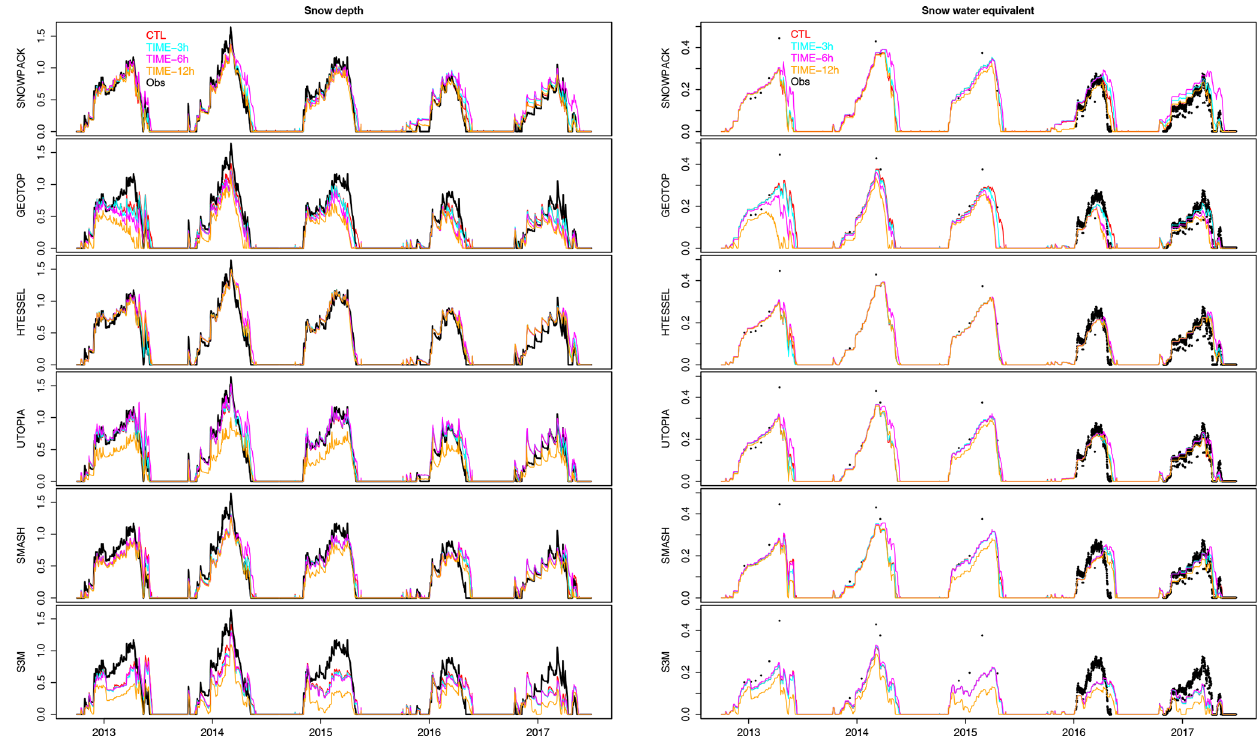
Figure 4. Model simulations of snow depth and SWE when the input is sampled at 3, 6 and 12h, compared to the CTL run and to the observations. The TIME-12h experiment employs the incoming shortwave radiation estimated with the potential radiation